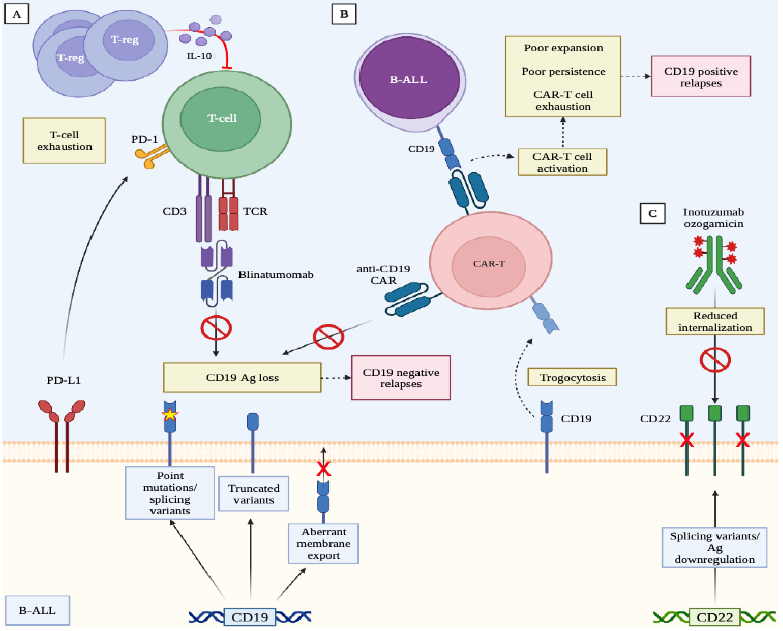
Figure 2. Mechanisms of relapse after exposure to different immunotherapies. Panel ( A ) T-cell activation and expansion can be impaired by the leukemia-derived mechanisms of immune escape, primarily antigen loss or phenomena derived from T-cell proliferation under chronic antigen stim- ulation, such as T-cell exhaustion. Panel ( B ) relapses after CAR-T cell infusion could be related to antigen loss (CD19-relapses) or to impaired CAR-T cell function (CD19+ relapses). Panel C: re- sistance to inotuzumab ozogamicin is mainly related to reduced CD22 expression and impaired drug